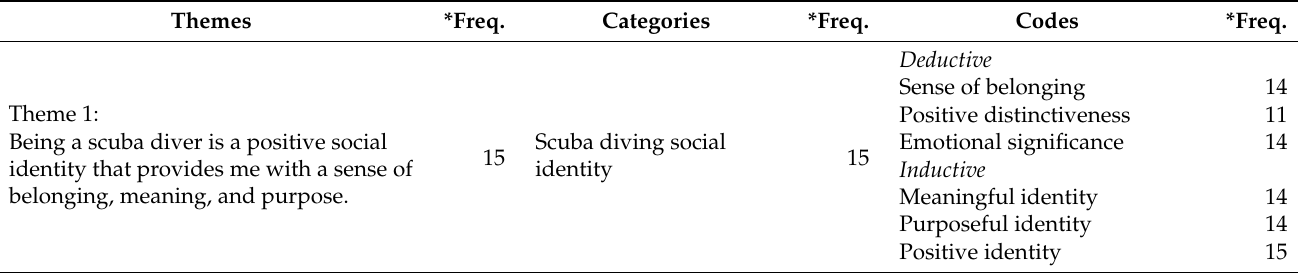
Table 7. Frequency results for qualitative themes, categories, and codes ( n =